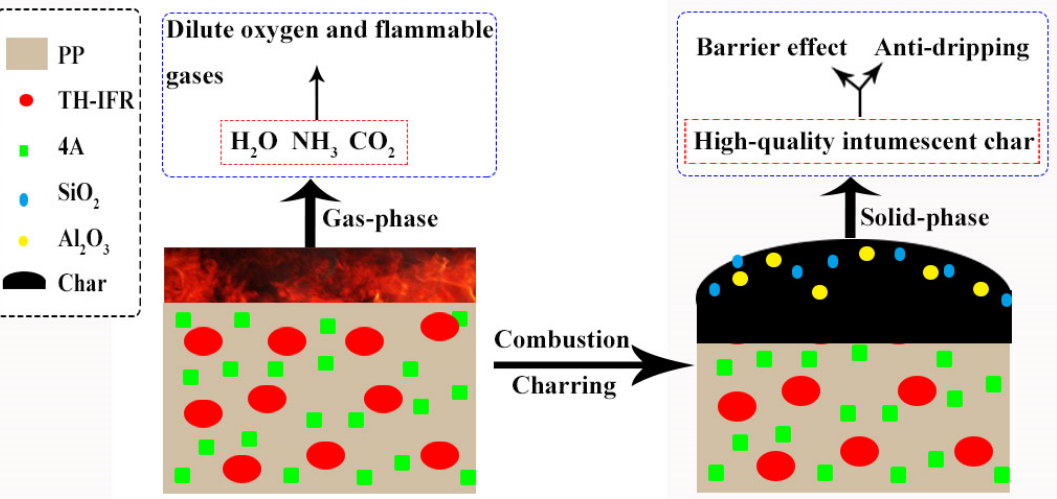
Figure 9. The schematic diagram of the synergistically flame-retarding mechanism.